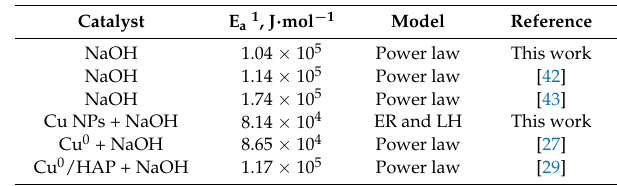
Table 8. Comparison of the obtained values of activation energies with those described in the